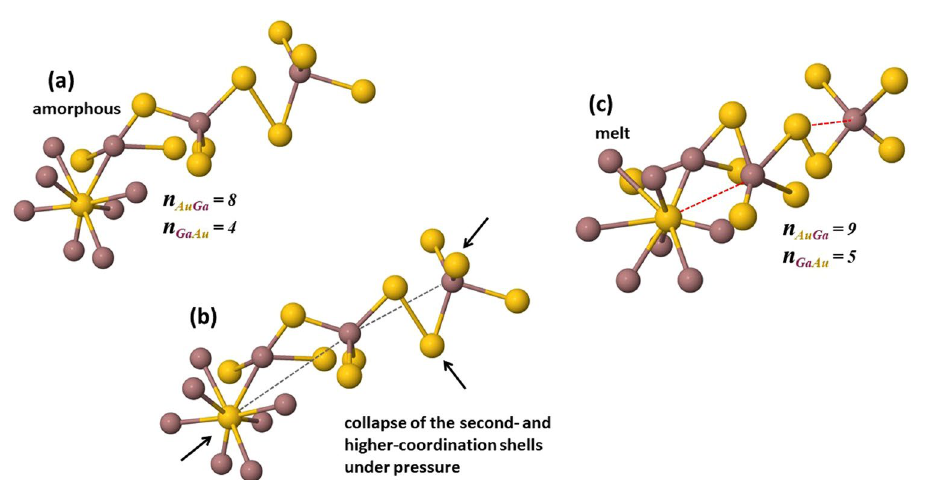
Figure 8. Schematic representation of densification mechanism and corresponding structural moieties in liquid AuGa 2 . Amorphous solid ( a ) includes GaAu 4 tetrahedral units connected to each other via Au-Au bonding and to AuGa 8 polyhedral units via Au-Ga bonding. Densification is dominated by large inward shifting of the second- and higher coordination shells under pressure ( b ). Melt-AuGa 2 obtained at highest pressure shows higher order polyhedral units, 5 and 9 coordination around Ga and Au atoms, respectively ( c